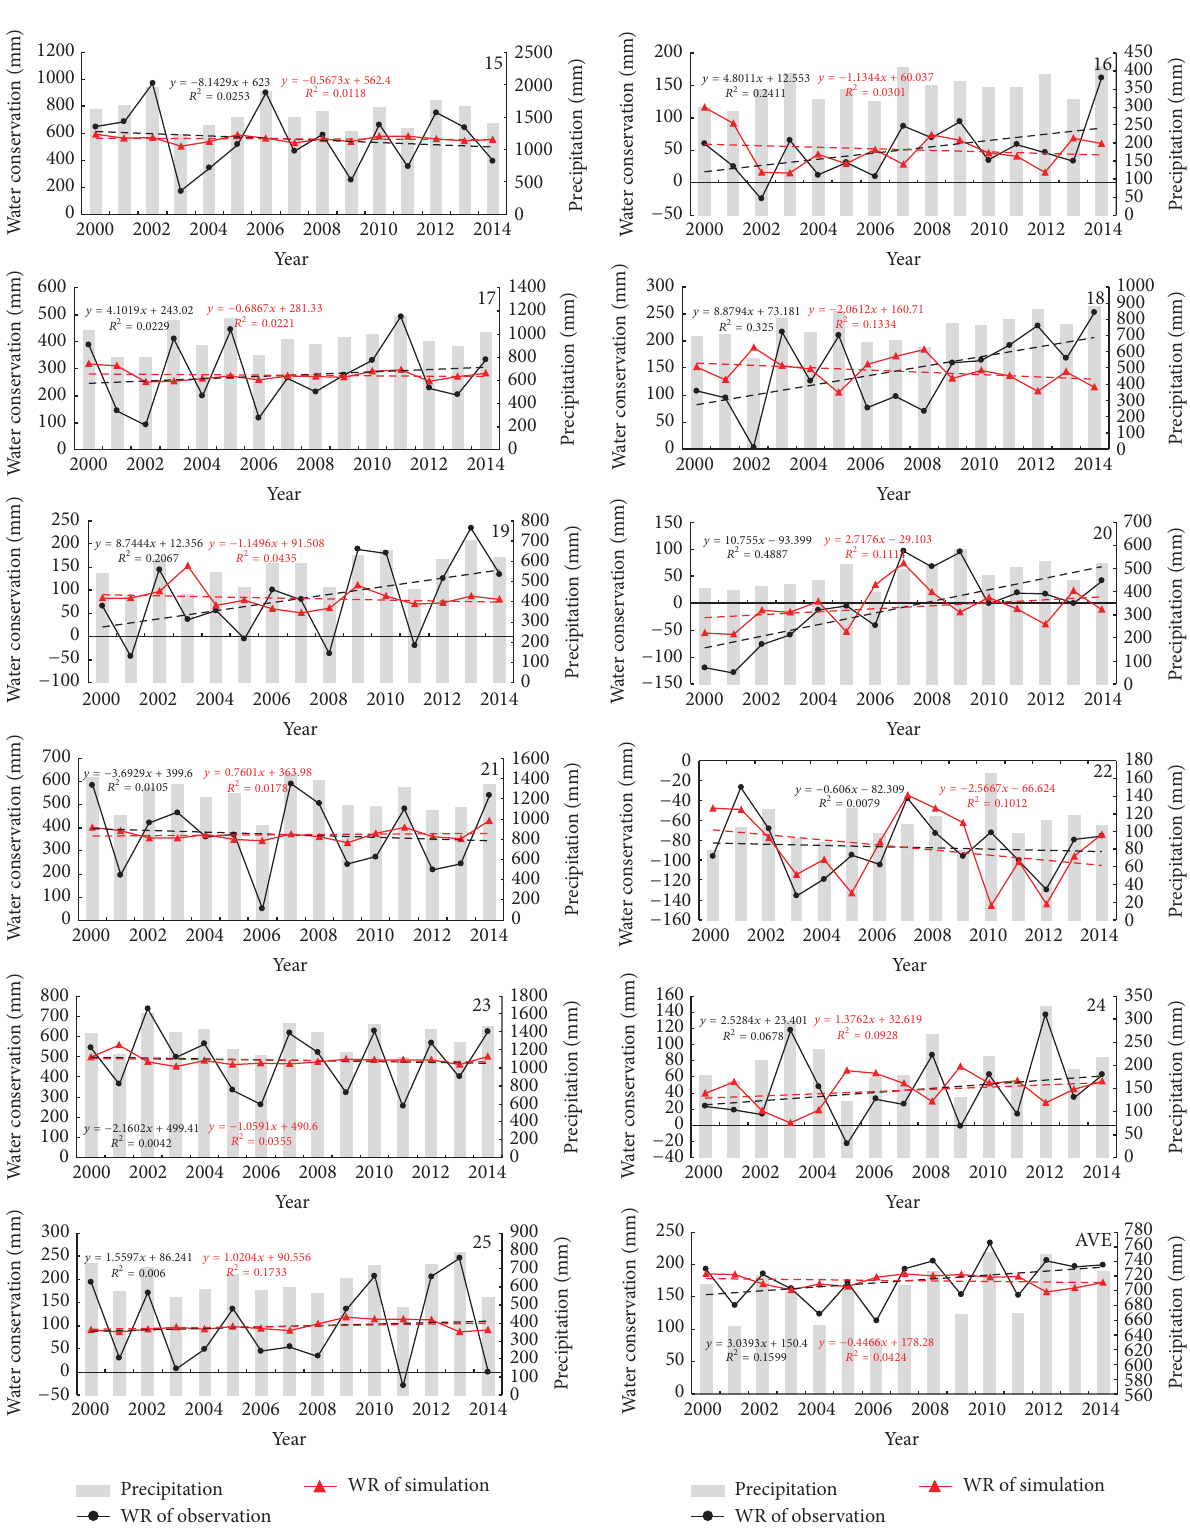
Figure 8: Mean water conservation and annual precipitation change in